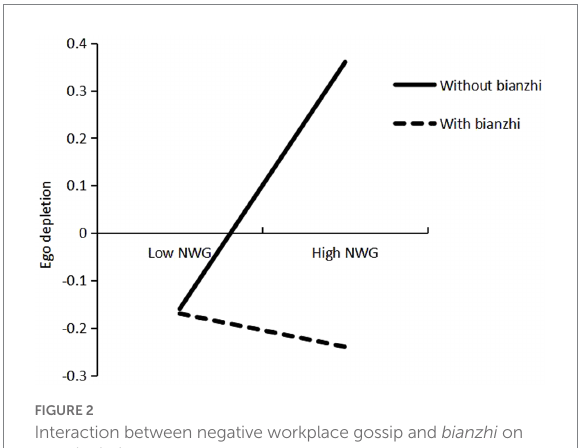
FIGURE 2 Interaction between negative workplace gossip and bianzhi on ego